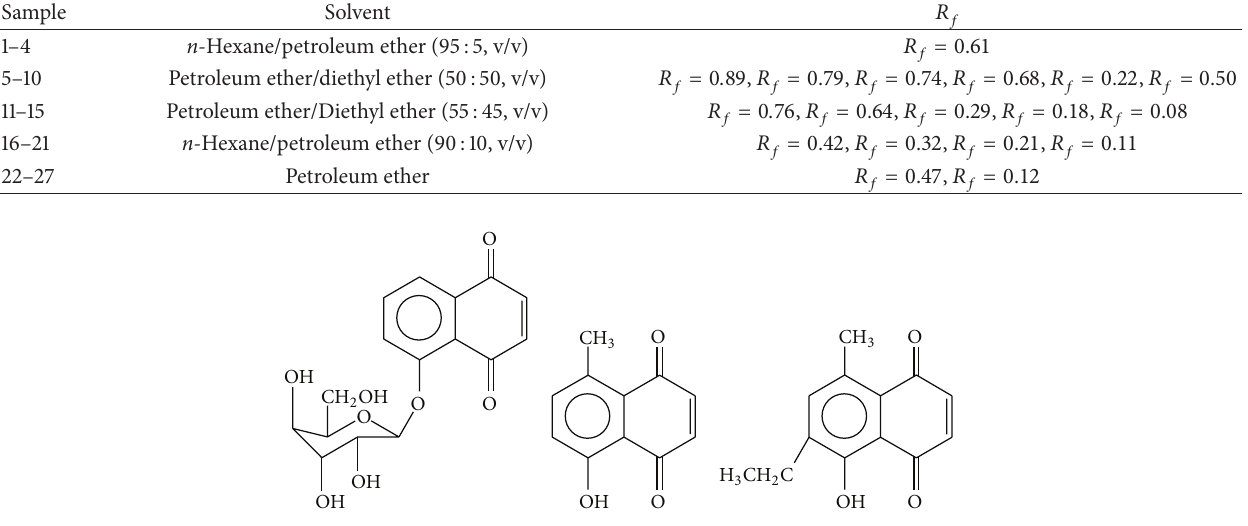
= 0.68 , and (c) petroleum ether/diethyl ether (55 :45, v/v), 𝑅 𝑓